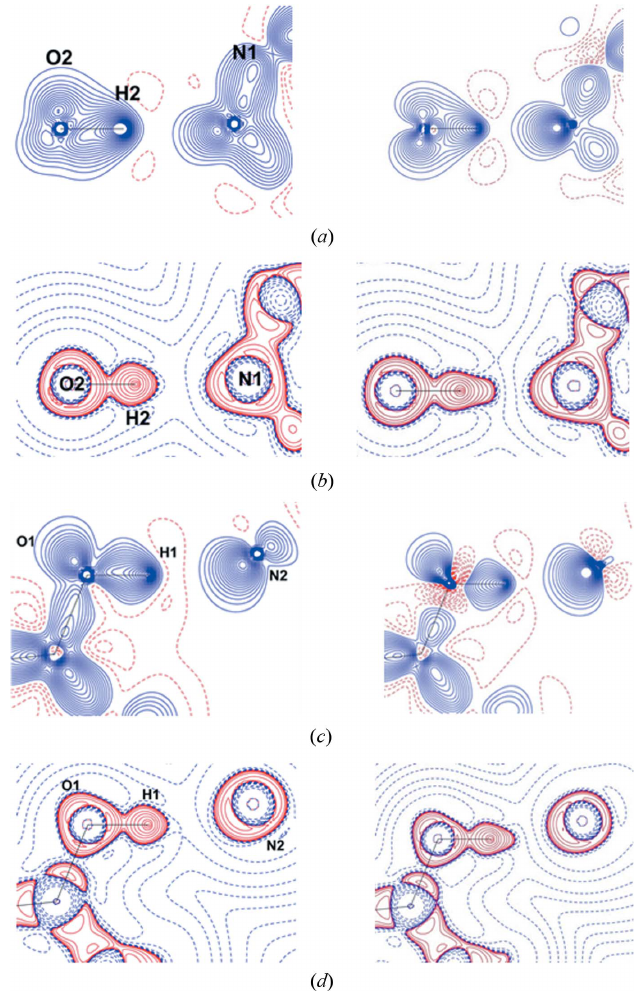
Figure 7 Comparison of deformation density and Laplacian maps [ (cid:3) (cid:8) ( r ) and r 2 (cid:8) ( r )] maps, obtained from SBFA (left) and theoretical calculations based on CRYSTAL09 (right), in O2—H2 (cid:2)(cid:2)(cid:2) N1 ( a , b ) and O1—H1 (cid:2)(cid:2)(cid:2) N2 ( c , d ) intermolecular space, respectively. (cid:3) (cid:8) ( r ) contours are drawn at (cid:8) 0.05 e A˚ (cid:4) 3 . r 2 (cid:8) ( r ) (e A˚ (cid:4) 5 ) drawn in logarithmic